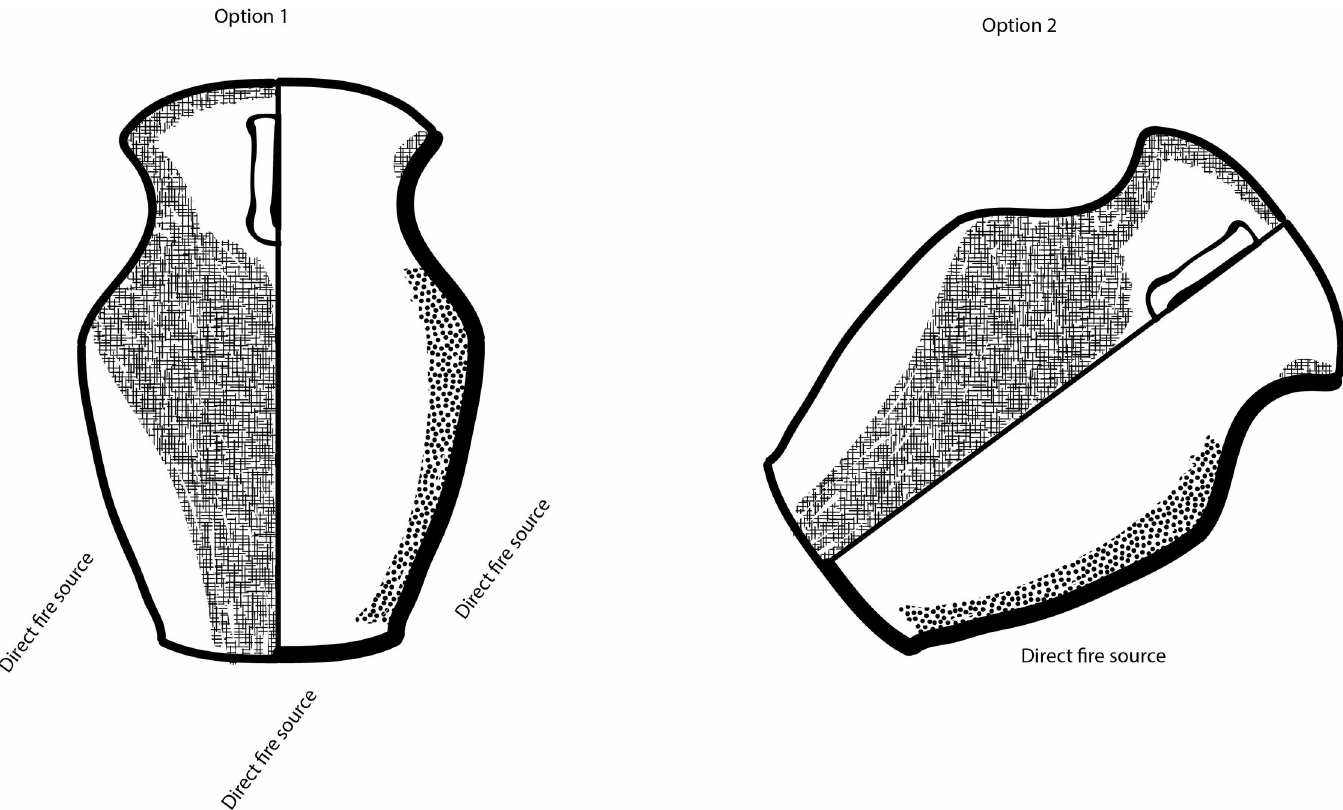
Fig 7. Possible positions that could have generated the dominant use-wear pattern observed on Siwa ma’an cooking vessels. Option 1: commonly understood use position for cooking vessels (it is possible that the vessel was exposed to a heat source on its sides). Option 2: more likely position given the lack of use-wear observed internally on the base of vessels.